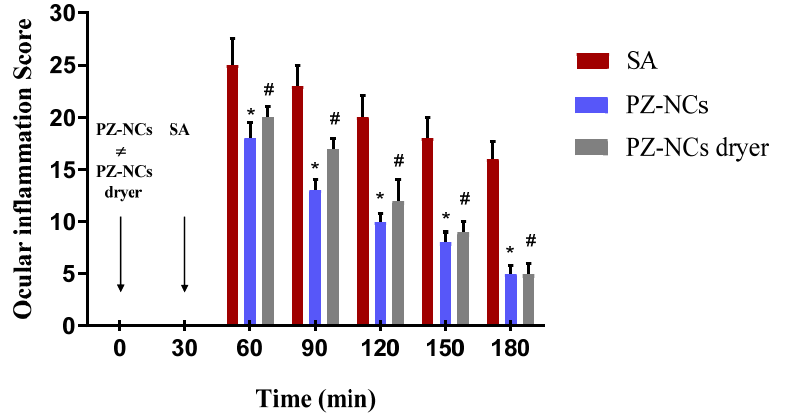
Figure 1. Comparison of prevention anti-inflammatory efficacy after sodium arachidonate (SA)-induced inflammation in the rabbit’s eye. Values are expressed as the average ± SD ( n = 3); * p < 0.05 comparison of PZ-NCs vs. positive control (SA); # p < 0.05 comparison of PZ-NCs dryer vs. positive control (SA).